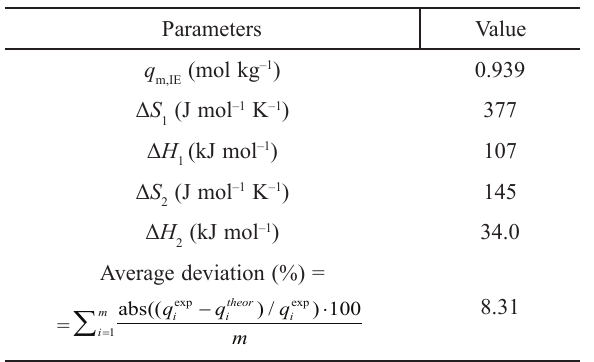
Table 4 – Equilibrium parameters in Eq. (20) of D-GA on the resin 201×7 Parameters